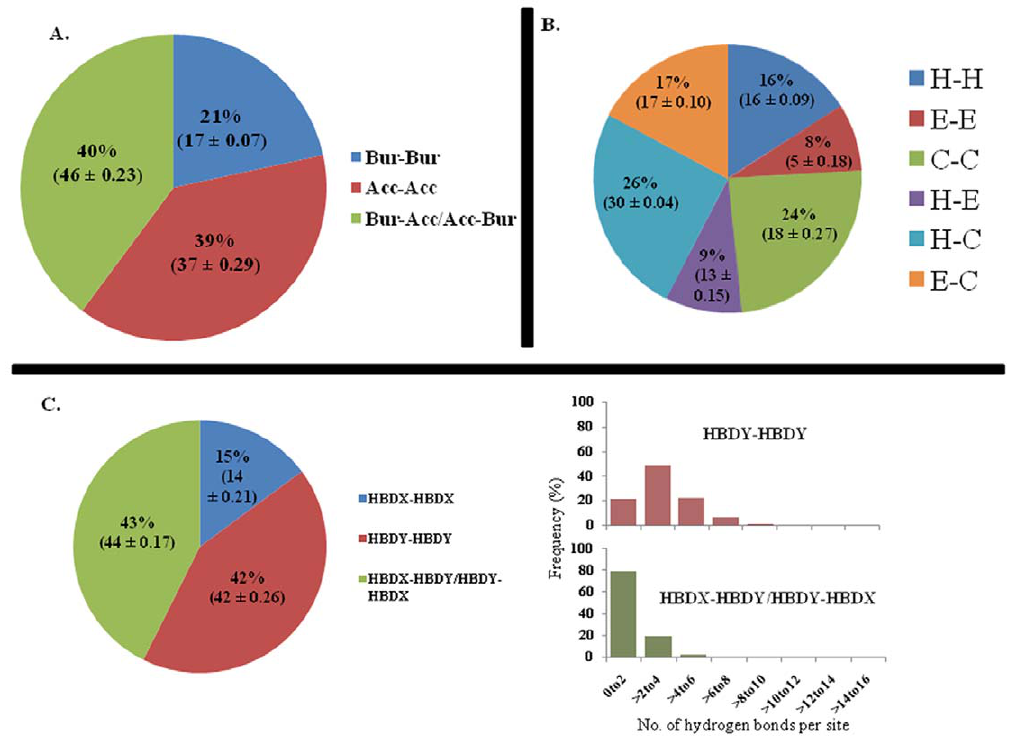
Figure 5. Percentage of sites with given structural properties is shown. Structural properties such as solvent accessibility (panel A), type of secondary structures (panel B) and hydrogen bonds (panel C) were calculated for coevolved sites. Solvent accessibility (Buried: Bur; Accessible: Acc) was measured using the PSA program from JOY package [44]. Within the coevolved site pairs, if both residues are buried or accessible, they are shown as ‘Bur-Bur’ or ‘Acc-Acc’, respectively. Secondary structure [helix (H), strand (E) and coil (C)] distribution for coevolved residue pairs is shown in panel B. Hydrogen bonding patterns were estimated using the HBOND programs from the JOY package. ‘HBDY-HBDY’ and ‘HBDX-HBDX’ indicate cases where both coevolved residues are involved or not involved in hydrogen bonding correspondingly. ‘HBDX-HBDY/HBDY-HBDX’ indicates cases where at least one residue is involved in hydrogen bonding. Values in the parenthesis show mean and standard error of estimated from the distribution of structural property values for randomly selected non-coevolved residue pairs (5 randomizations were